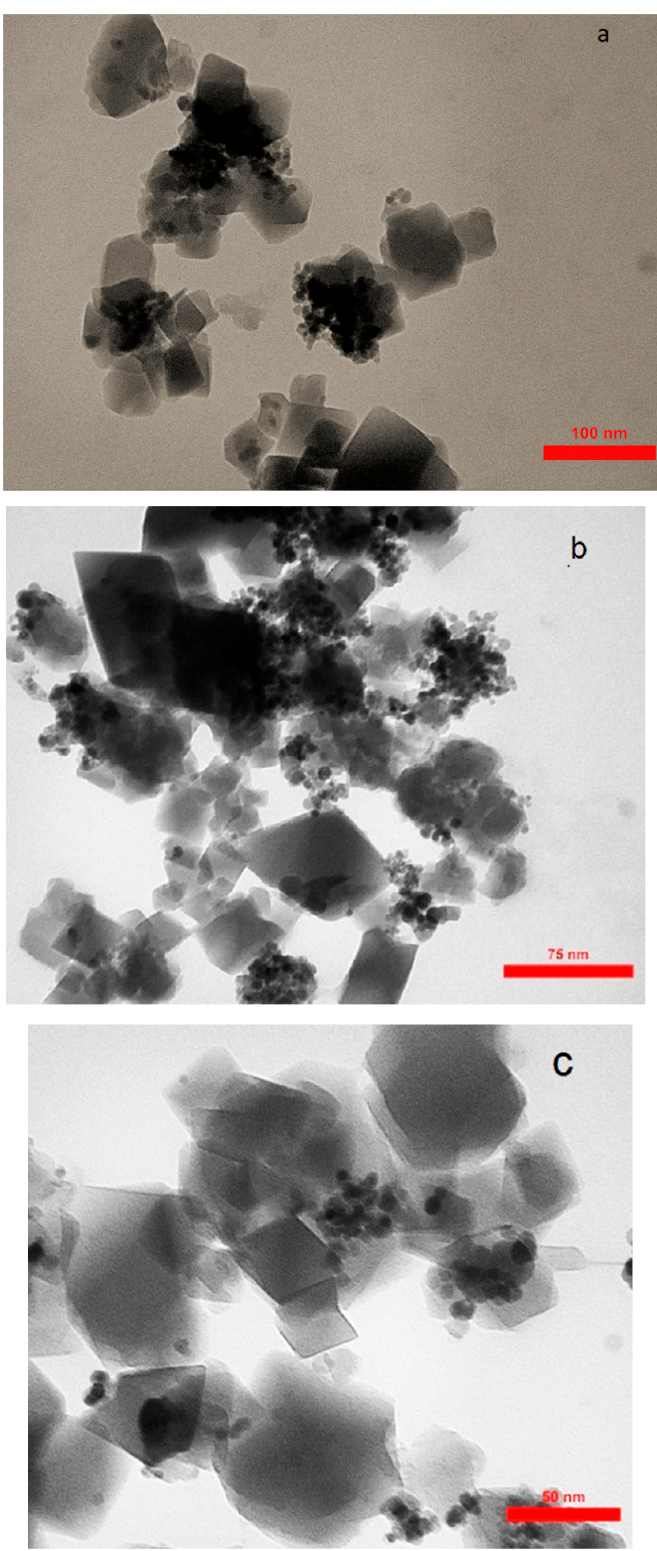
Figure 3. FESEM images ( a , b ) AC ( c , d ) Fe 3 O 4 @AC, and ( e , f ) MIL-100(Fe) @Fe 3 O 4 @AC.